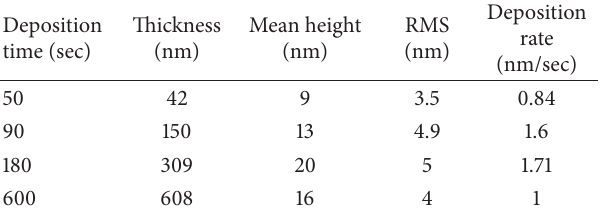
Table 1: Details of AFM analysis of C-Ni composite